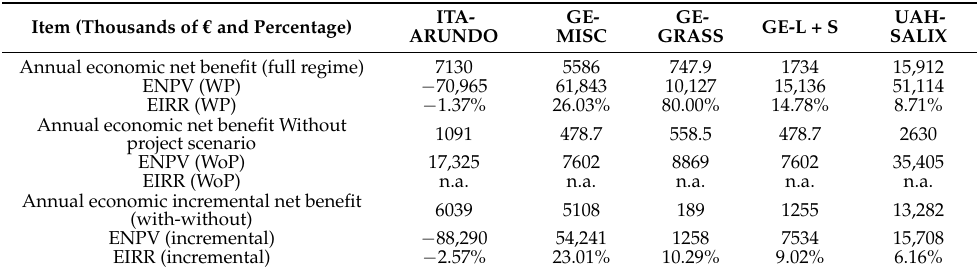
Table 6. WP, WoP and incremental economic ENPV and EIRR